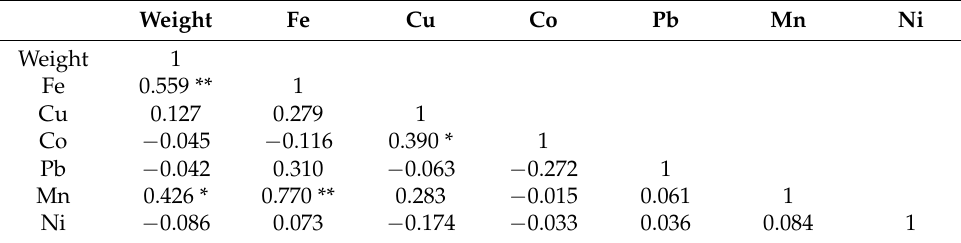
Table 6. Correlation between metal concentrations in the soft tissues of Strombus canarium and dry